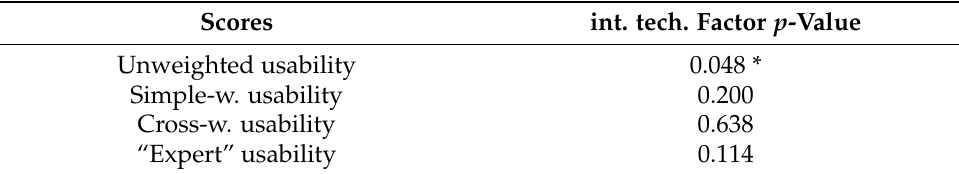
Table 8. HMD application: repeated-measures ANOVA on usability scores with interaction technique, scenario, and order